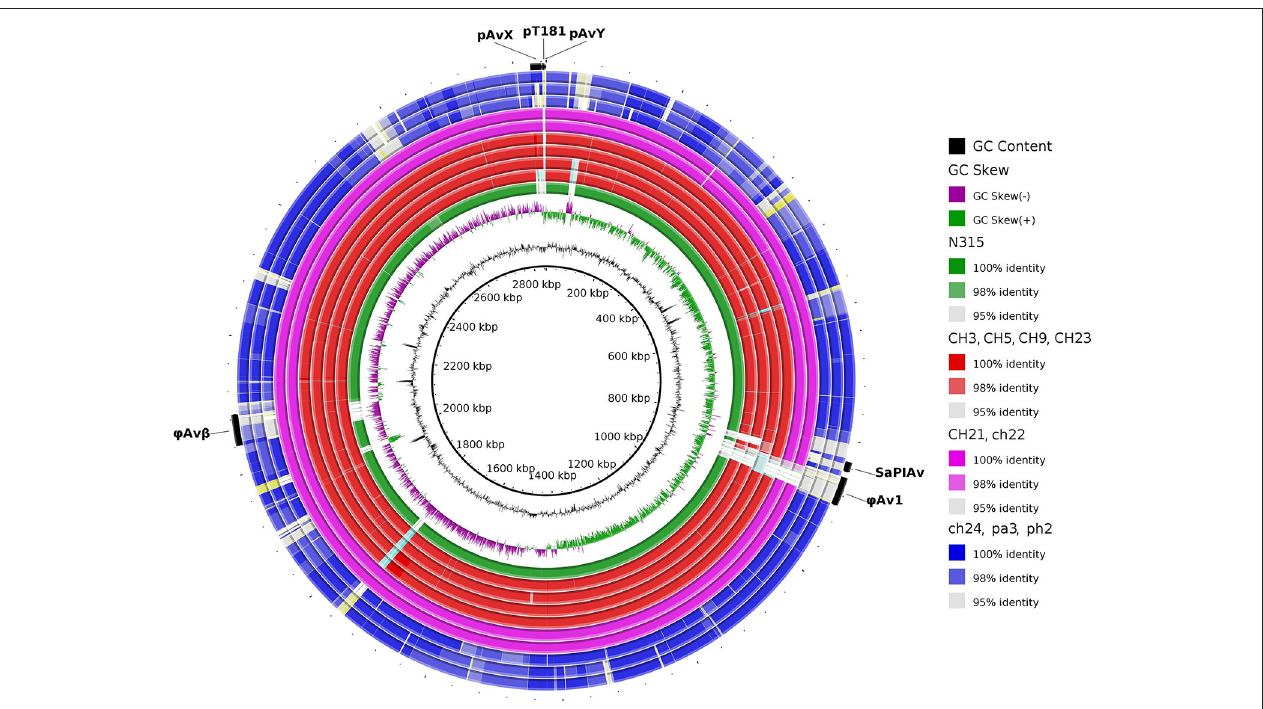
FIGURE 4 | Visual comparison of genomes of poultry-origin S. aureus strains against a reference strain ED98. The group of virulent strains is genetically more homogenous when compared with the more diverse group of non-virulent strains. Particularly regarding indistinguishable CH21 and ch22 strains. Noticeably, mobile genetic elements such as prophages ϕ Av1, ϕ Av β and pathogenicity island SaPIAv seem to be characteristic for the ST5 poultry subgroup. Human-origin MRSA strain N315 belonging to ST5 was also